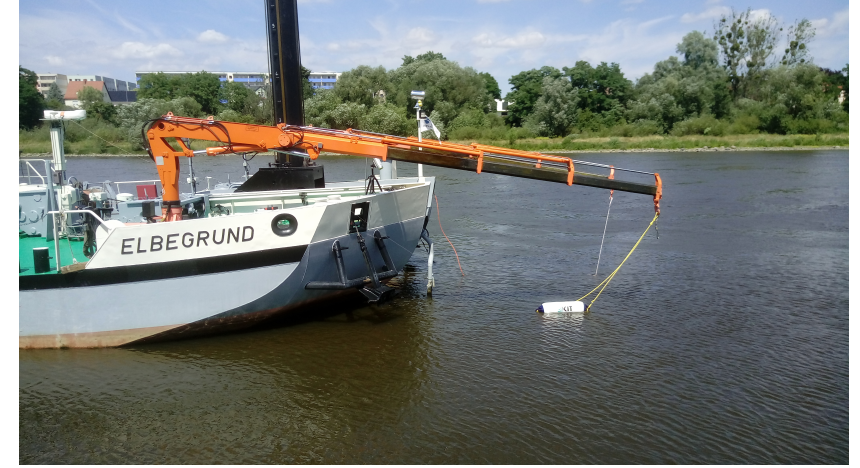
Figure 2. Application of the Biofish sensor system (white floating cylinder) from the research vessel Elbegrund in the river